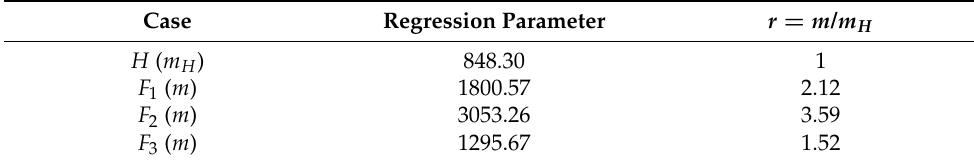
Figure 7. Data fusion for each case in Table 1: H (blue), F 1 (red), F 2 (orange), and F 3 (green), under the second experiment. This figure is related to Table 4: both indicates a pitch actuator fault detection. Table 5. Second numerical experiment